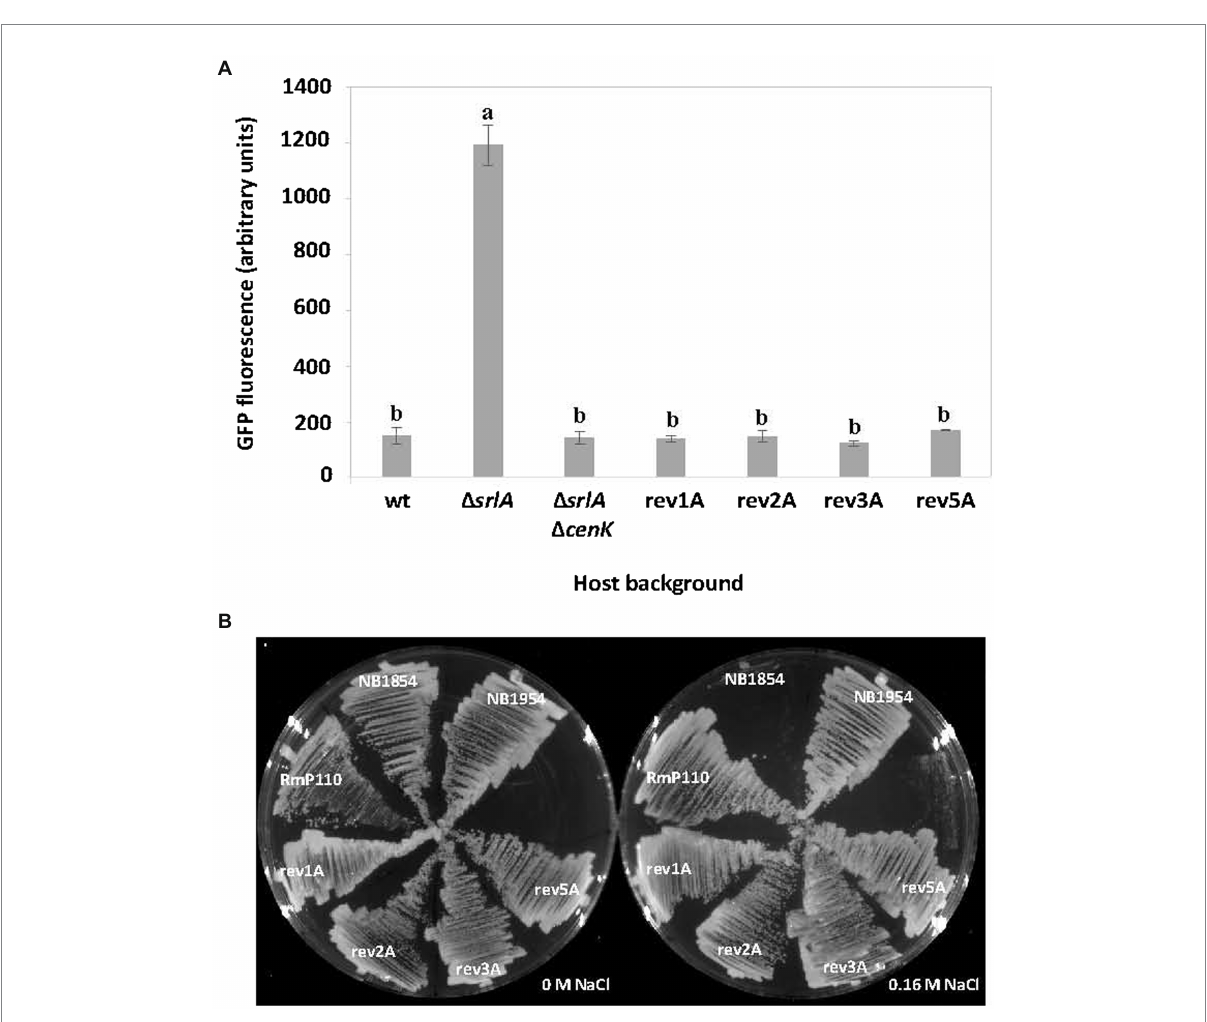
FIGURE 8 The effect of host cenK and cenR mutations on srlA promoter activity and salt-sensitivity. (A) transcription activity detected from srlA - gfp transcriptional fusion in plasmid pEB57 in genetic hosts: RmP110 (wt), NB1854 ( ∆ srlA ), NB1954 ( ∆ srlA ∆ cenK ), and revertant strains 1A, 2A, 3A, and 5A (see Table 2 for revertant strain genotypes). GFP activity reported as mean ± sd, n = 3. Letters indicate whether means are significantly different ( p < 0.01, ANOVA and Tukey HSD). (B) growth of strains on LB medium supplemented with 0 and 0.16 M NaCl.